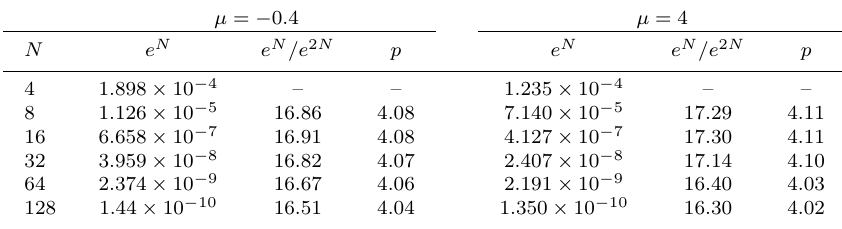
Table 1. Eq. (6.1); cubic collocation with the Gauss points. Maximum of errors at mesh points and convergence rates. µ = − 0 . 4 µ = 4